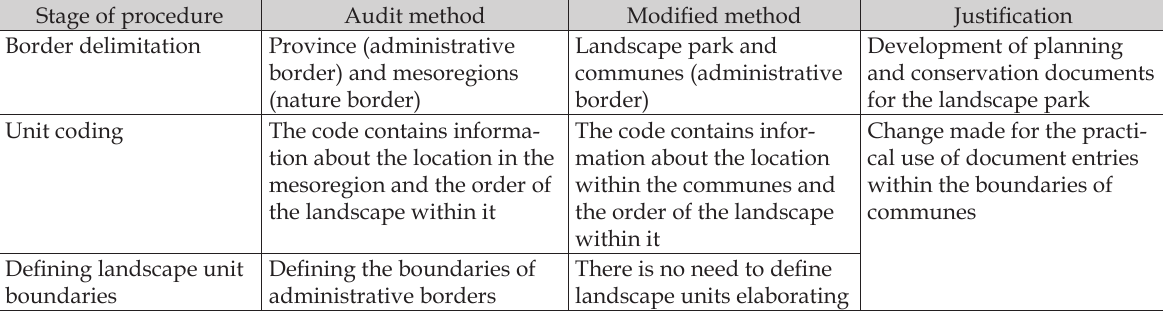
Table 2. Stages of methodological proceedings in the audit method and modified method. Stage of